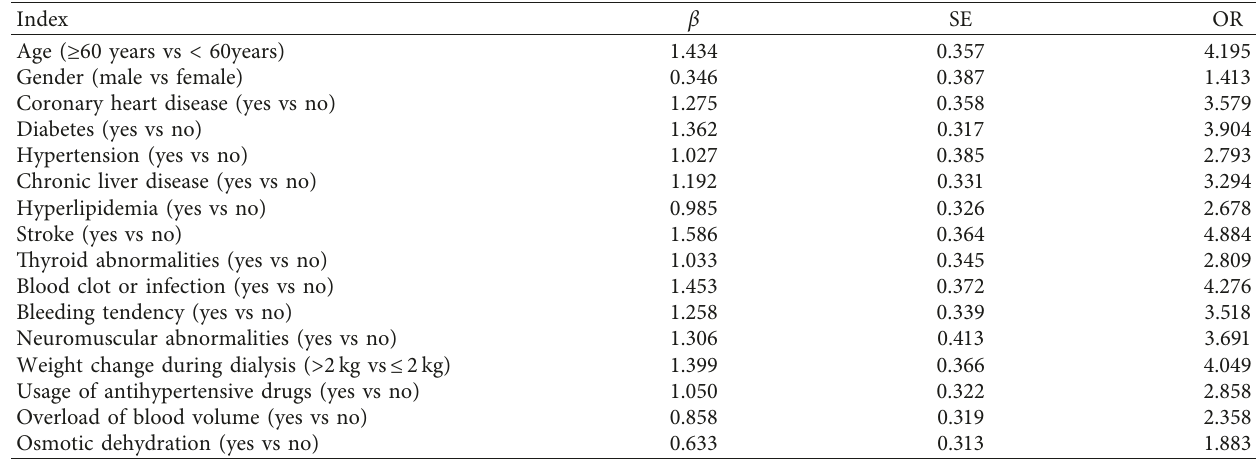
Table 2: Analysis of risk factors in ARF patients.